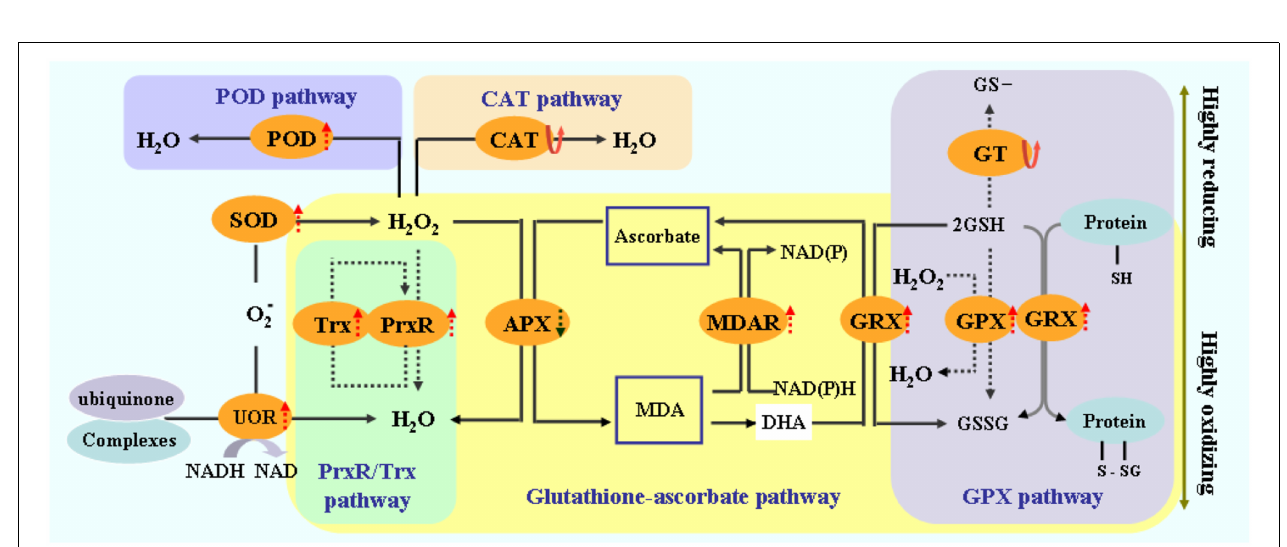
FIGURE 10 | Schematic presentation of salinity stress-responsive proteins involved in redox homeostasis in T. Nitraria seedling leaves.